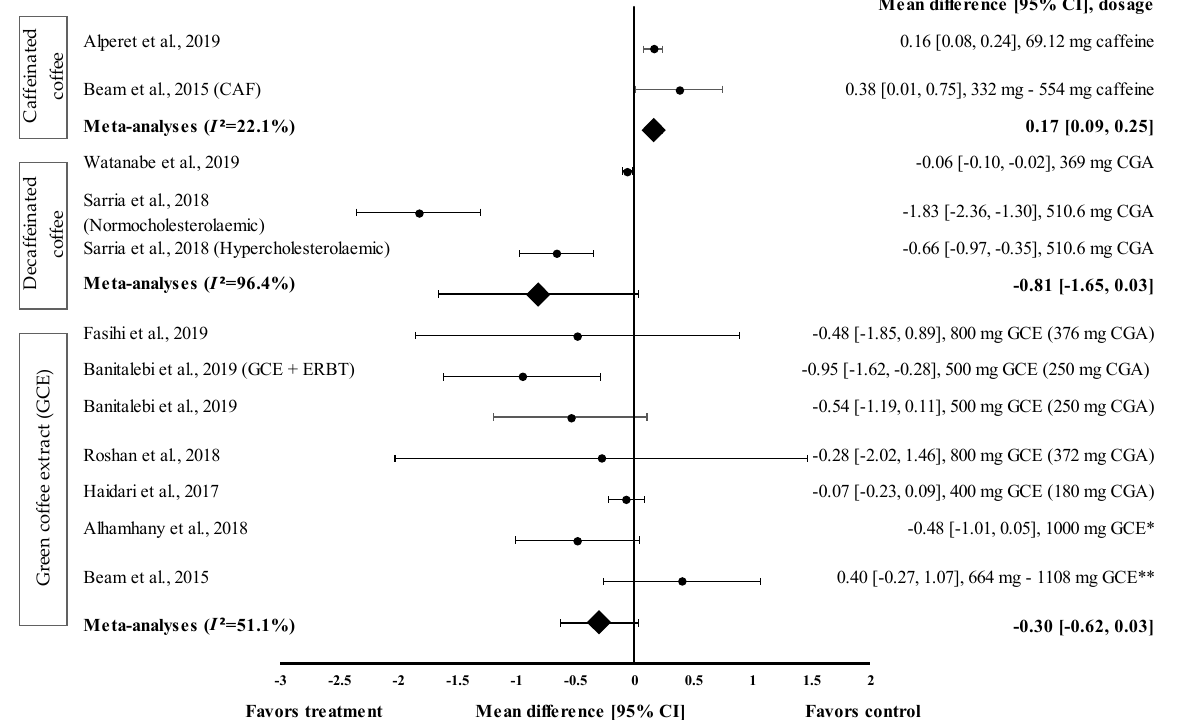
Figure 3. Forest plot showing the effect of caffeinated coffee, decaffeinated coffee, and GCE on FBG levels, expressed as mean differences between the values obtained from the intervention and control groups. A negative effect size indicates that decaffeinated coffee and GCE supplements reduce FBG levels. Meanwhile, a positive effect size indicates that caffeinated coffee and GCE supplements increase FBG levels. Horizontal lines represent 95% CIs. Diamonds represent the pooled effect size from random effects analysis. CAF: caffeine, CGA: chlorogenic acid, CI: confidence interval, ERBT: elastic resistance band training, FBG: fasting blood glucose, GCE: green coffee extract. The values ± 0.2, ± 0.5 and ± 0.8 represent small, medium, and large effect sizes. * CGA dose not specified, ** CGA content: 332–554 mg [20–22,25,26,28–31].